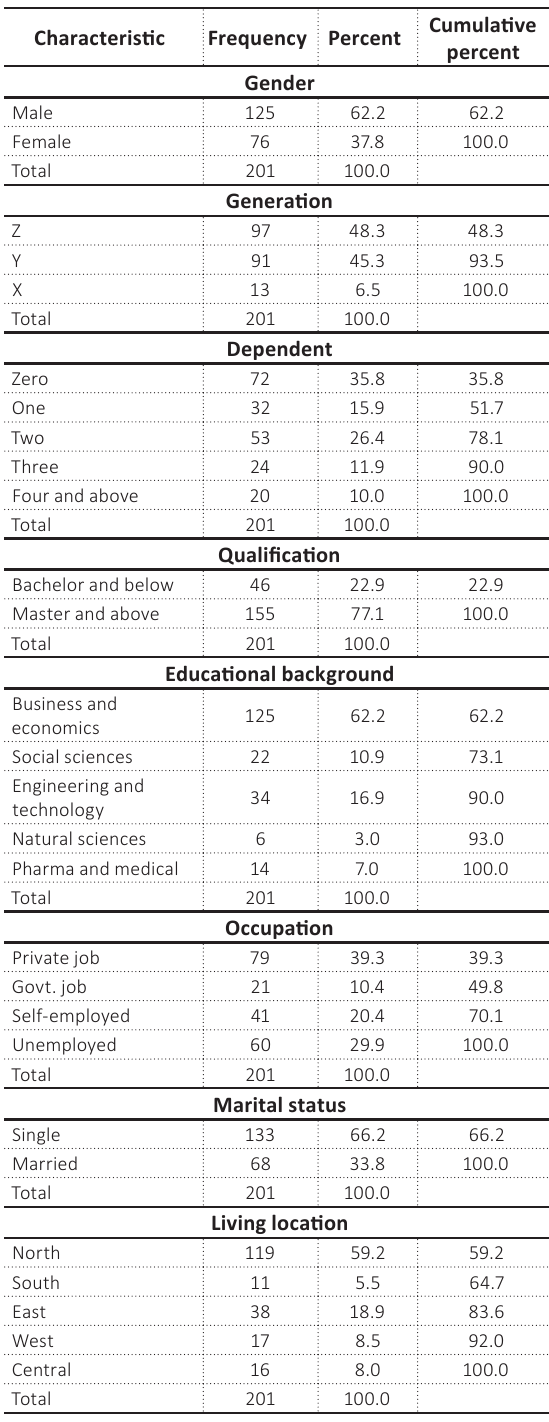
Table 3. Sample profile